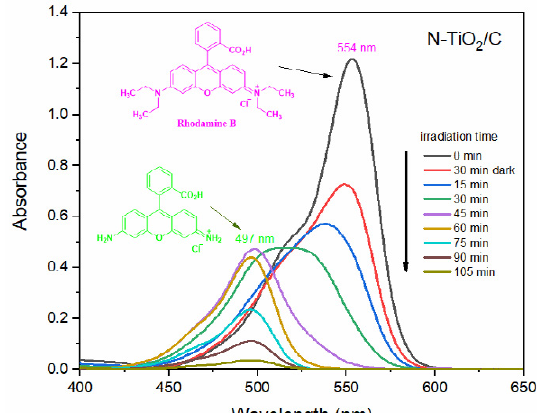
Fig. 12. UV-Vis spectral changes of an RhB solution under visible light irradiation and in the presence of N -TiO 2 /C.